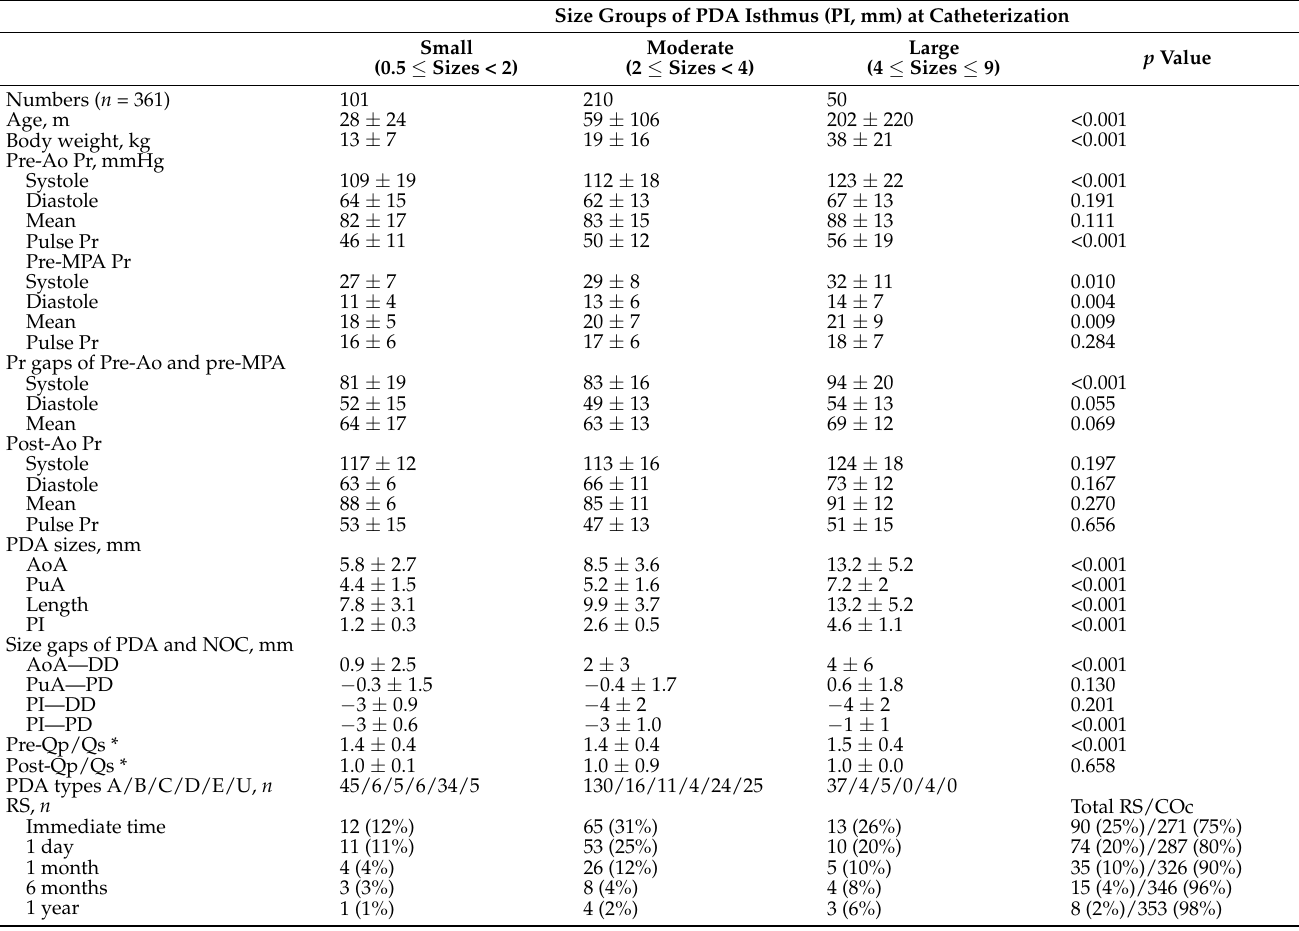
Table 2. Characteristics of PDA occlusion using NOC according to the PDA size groups. Size Groups of PDA Isthmus (PI, mm) at Catheterization Large Small Moderate (4 ≤ Sizes ≤ (0.5 ≤ Sizes < 2) (2 ≤ Sizes < 4)